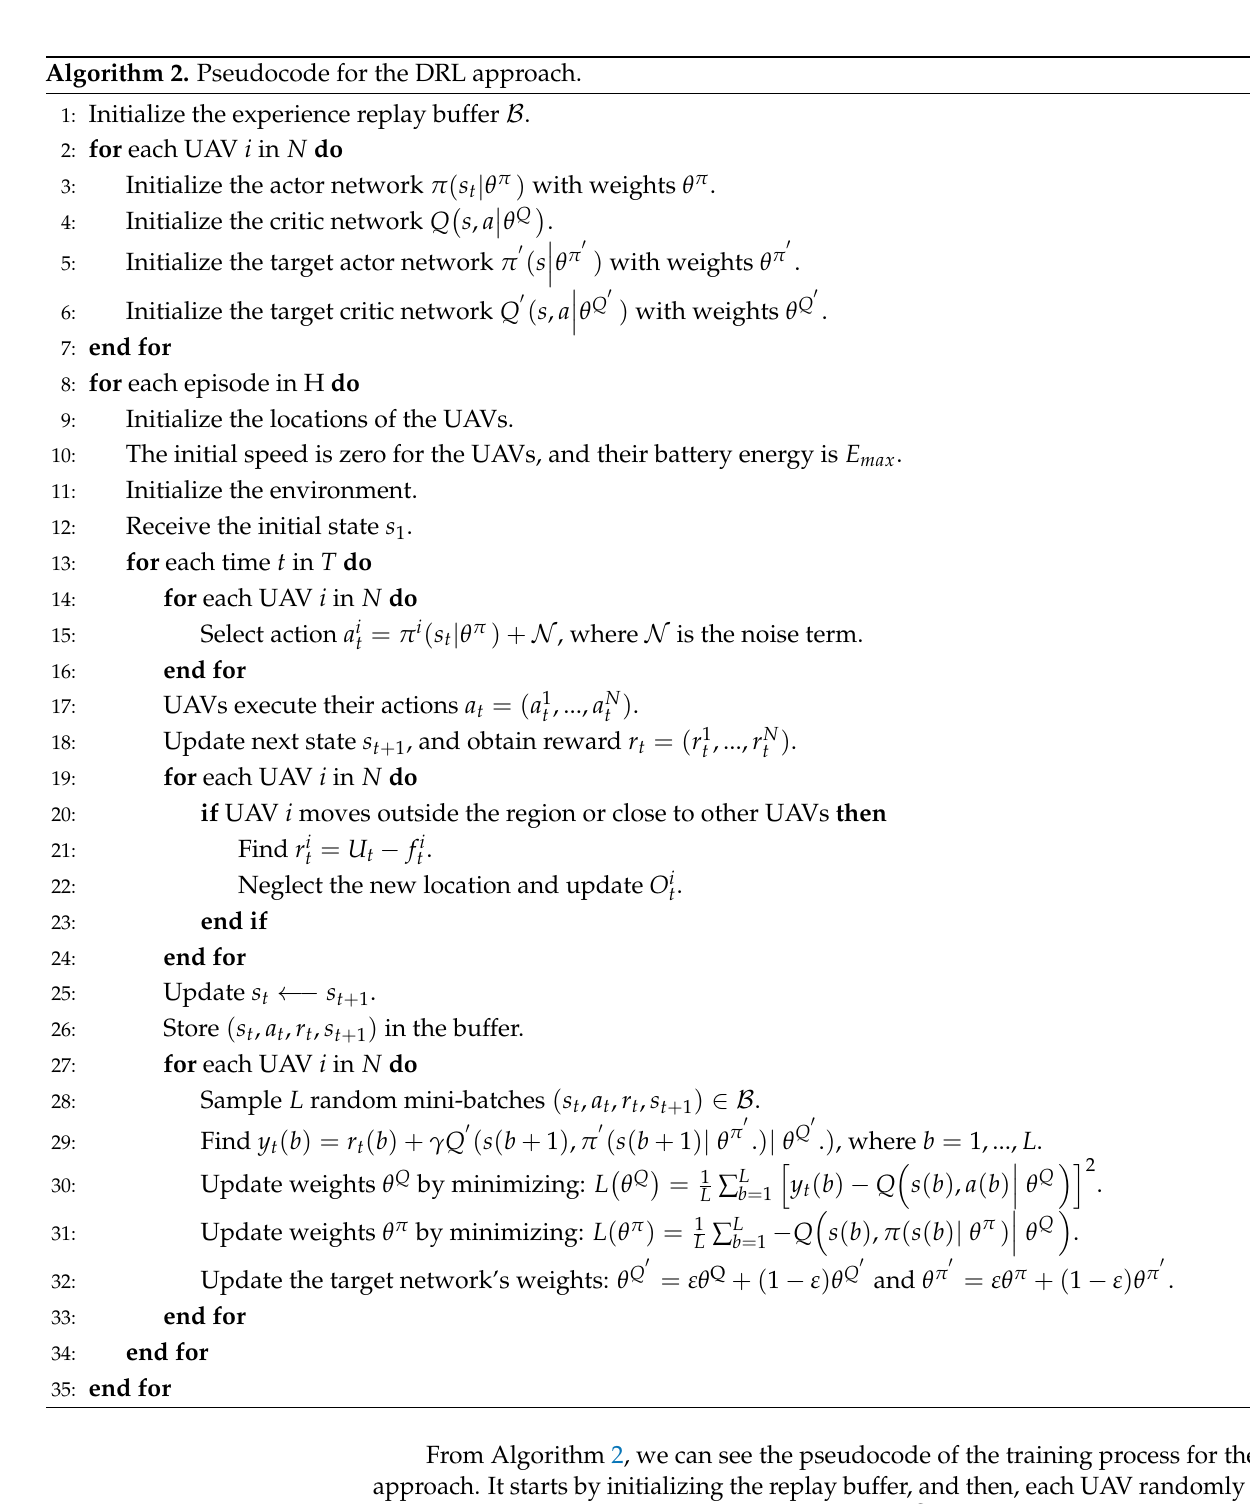
Algorithm 2. Pseudocode for the DRL